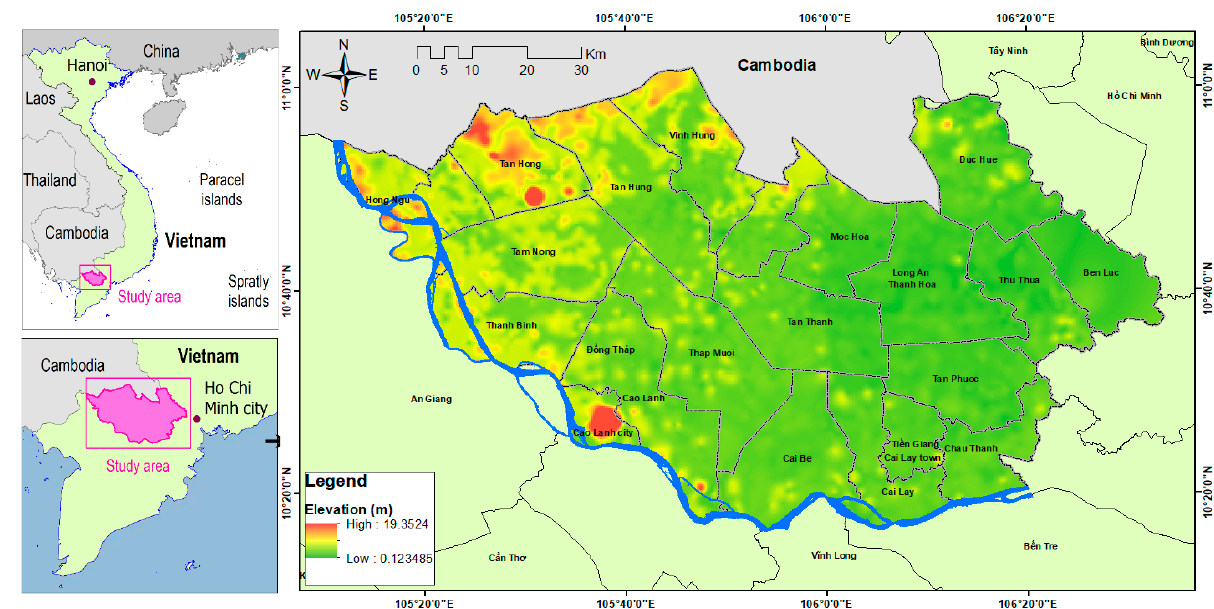
Figure 1. Location of the Dong Thap Muoi area.